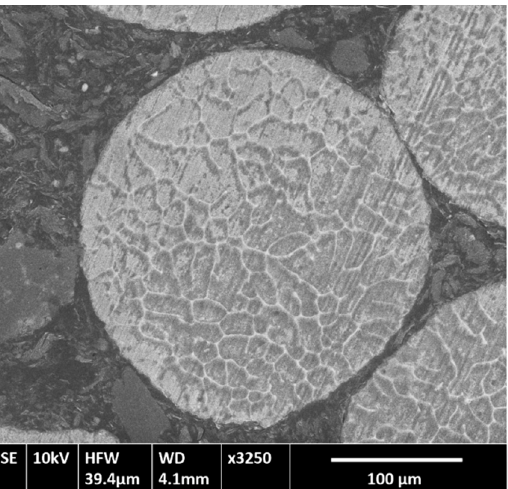
Figure 3. Cross section of a particle showing the typical cellular and dendritic-like morphology.